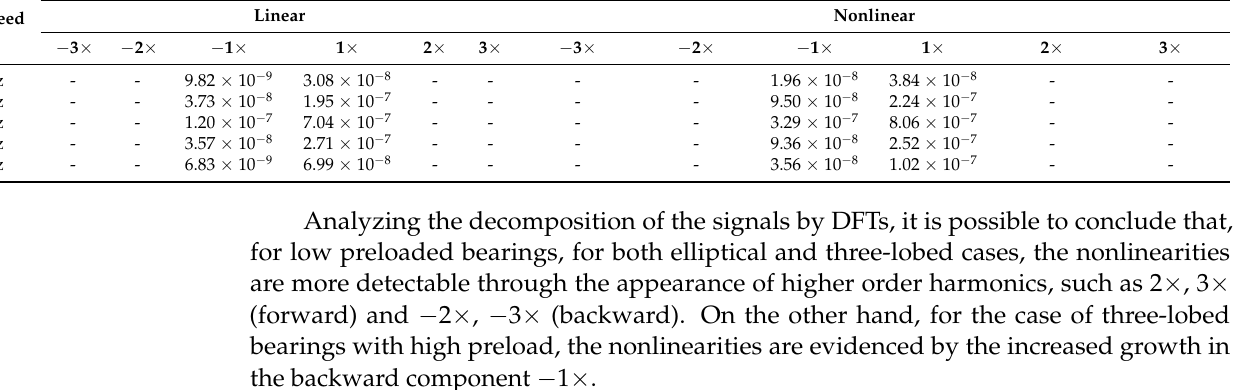
Figure 12. DFT full spectrum of simulated results in three-lobed bearing 1 (preload 0.8): ( a ) linear, ( b ) nonlinear. Table 4. Magnitudes of the most relevant peaks of Figure 12—three-lobed bearing (preload 0.8). Rot. Speed